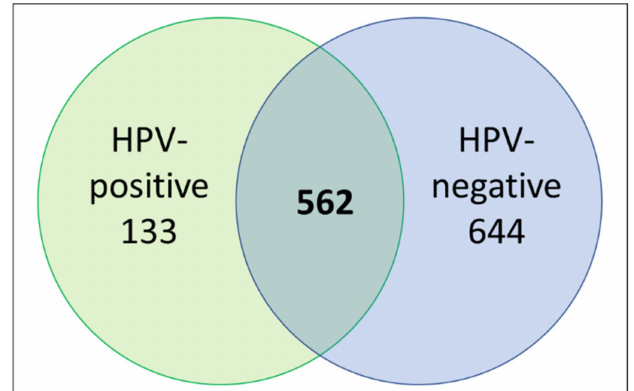
Figure 5. Venn diagram illustrating the distribution of proteins in EVs released from HPV-positive and HPV-negative HNSCC cell lines by averaged PSM